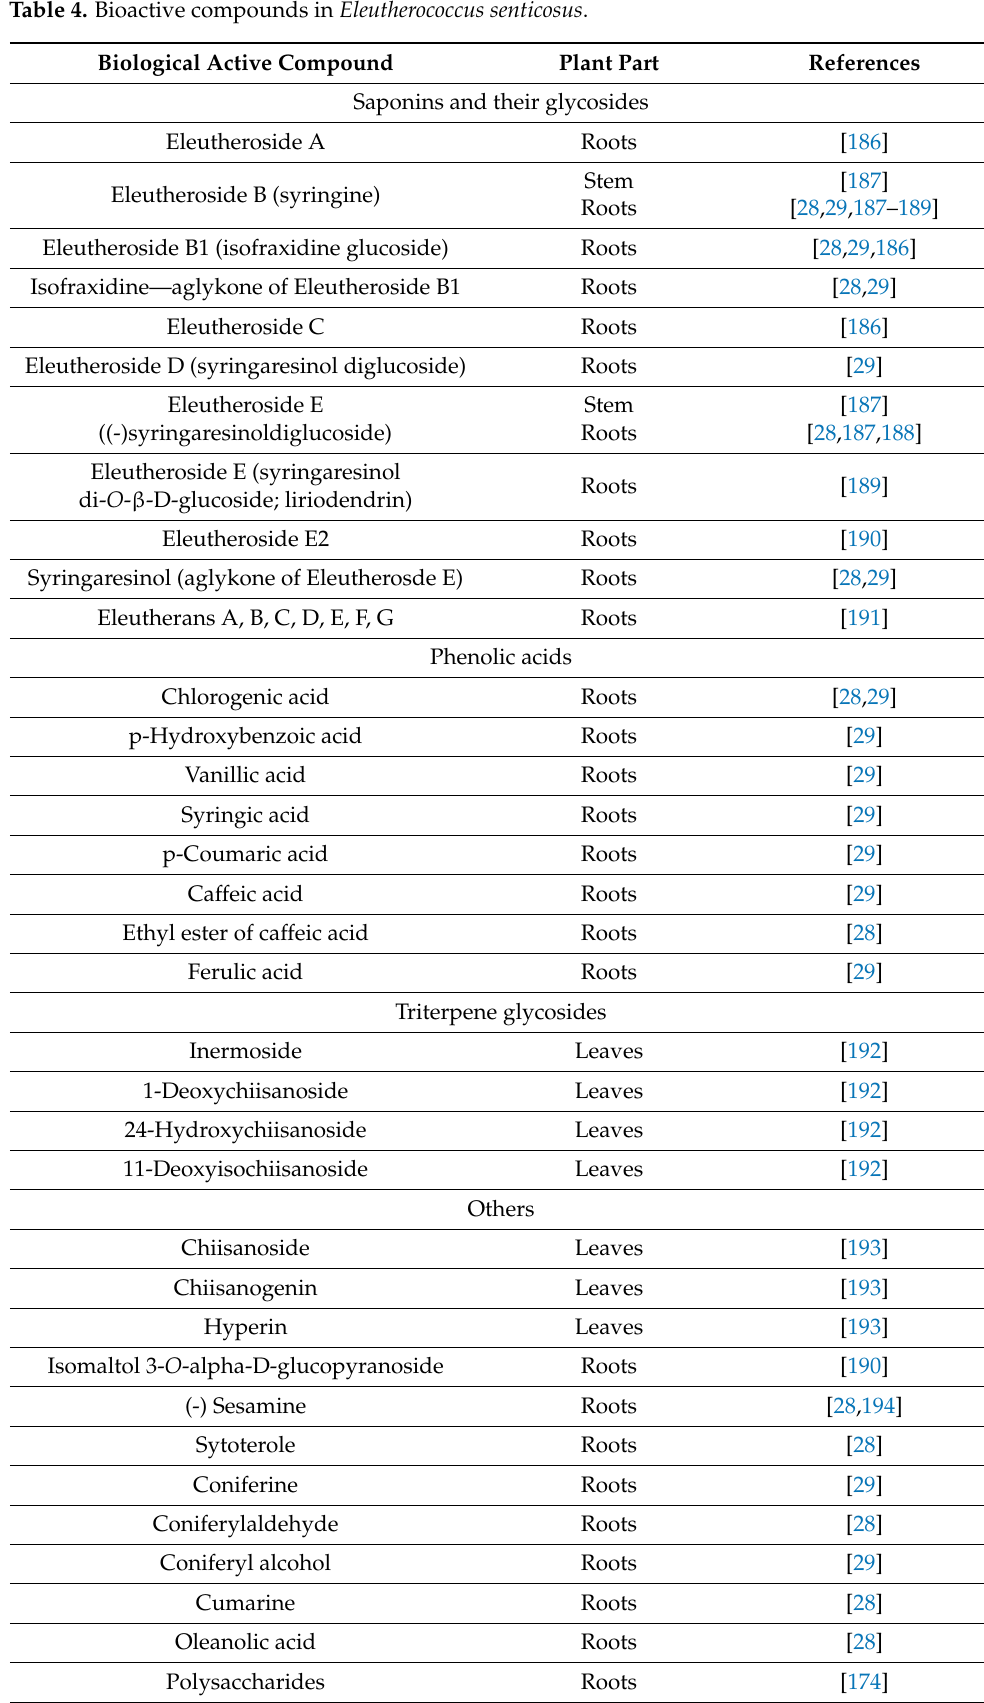
Table 4. Bioactive compounds in Eleutherococcus senticosus